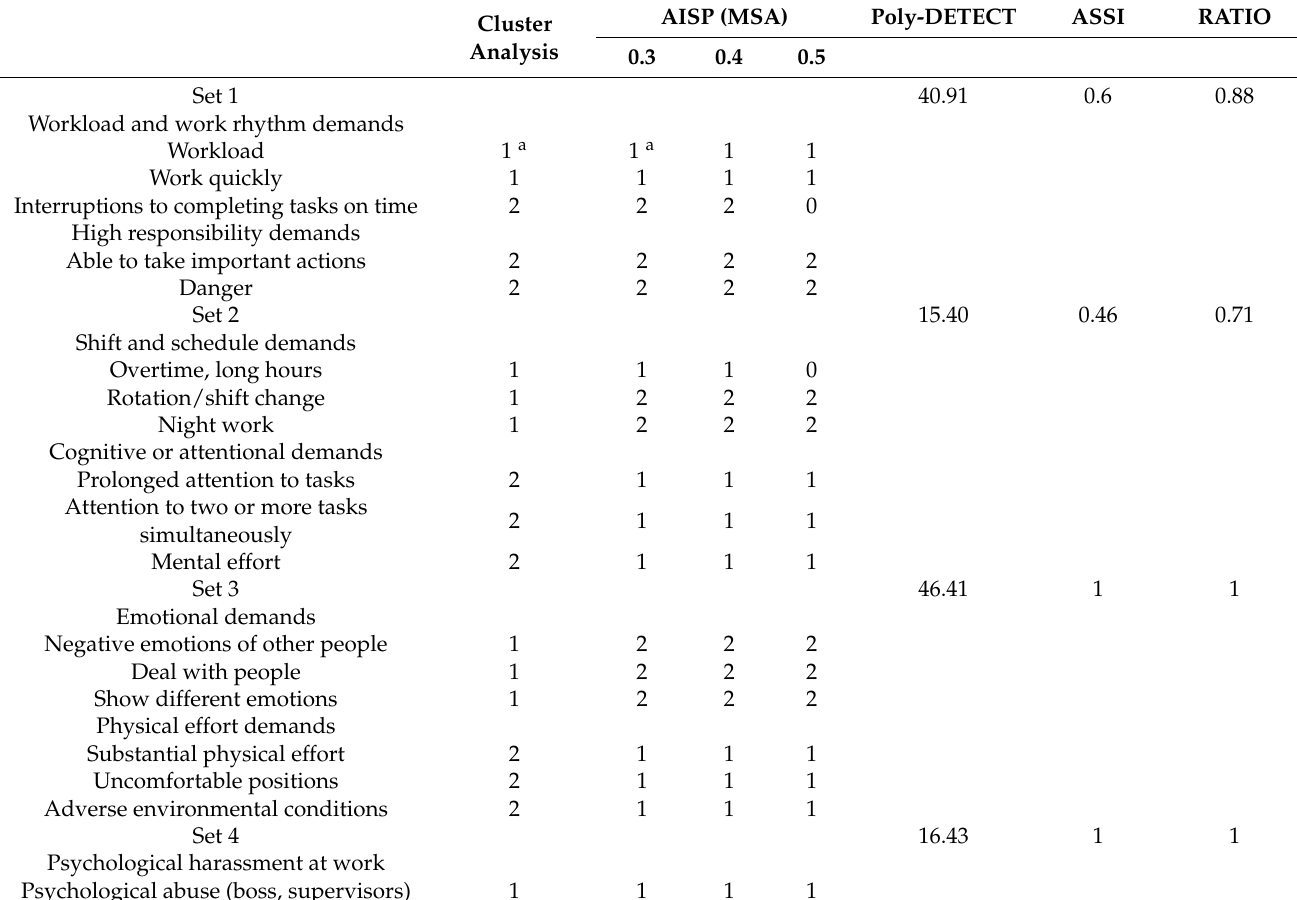
Table 2. Nonparametric assessment: psychosocial risk factor